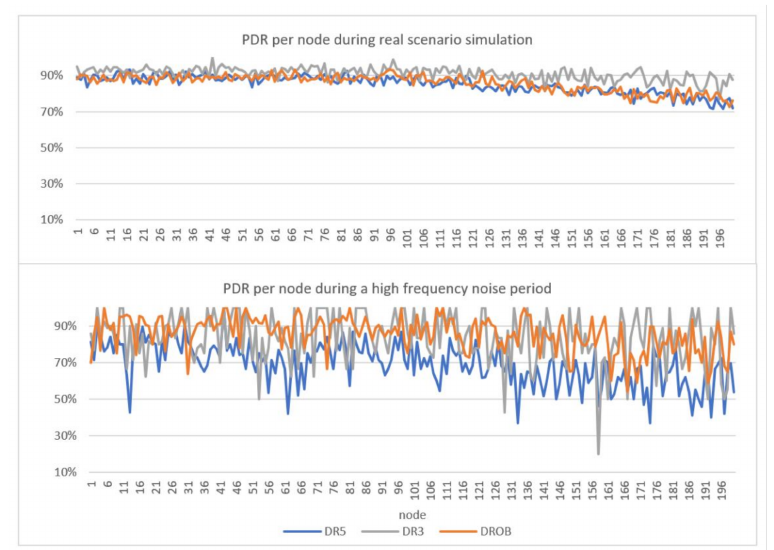
Figure 11. PDR for downlink results for each node in the network during the 24 h of the real scenario, and during one of the high frequency noise